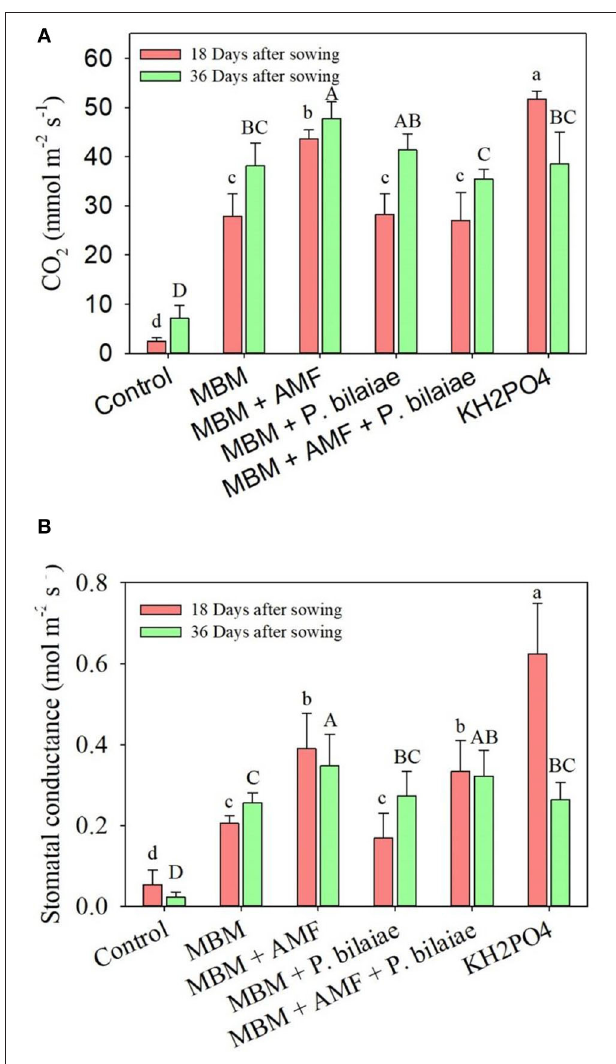
FIGURE 5 | Plant photosynthesis rate (A) and stomatal conductance (B) as affected by different P fertilizers and P mobilizers (arbuscular mycorrhizae fungi (AMF) and P. bilaiae ). Different alphabetical letters signify the statistical difference (Tukey test, p < 0.05) across the treatments. Error bar represents the mean ± SD ( n =